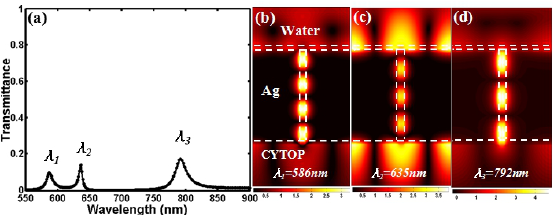
Fig. 2. Transmission spectrum of nanoslit arrays with P =500 nm, D =460 nm, W =25 nm, t =20 nm (a). Calculated magnetic field distributions at resonant peaks of λ 1 (b), and λ 2 (c), λ 3 (d), respec- tively. The white dotted lines mark the boundaries of the structure.